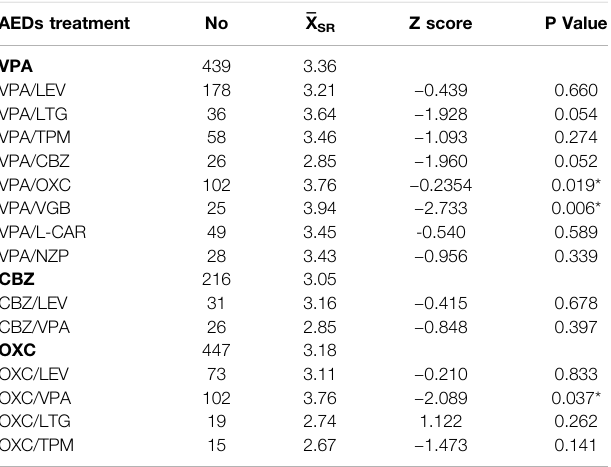
TABLE 3 | Comparative ef fi cacy of VPA, CBZ and OXC with additionally single drug combination. AEDs treatment